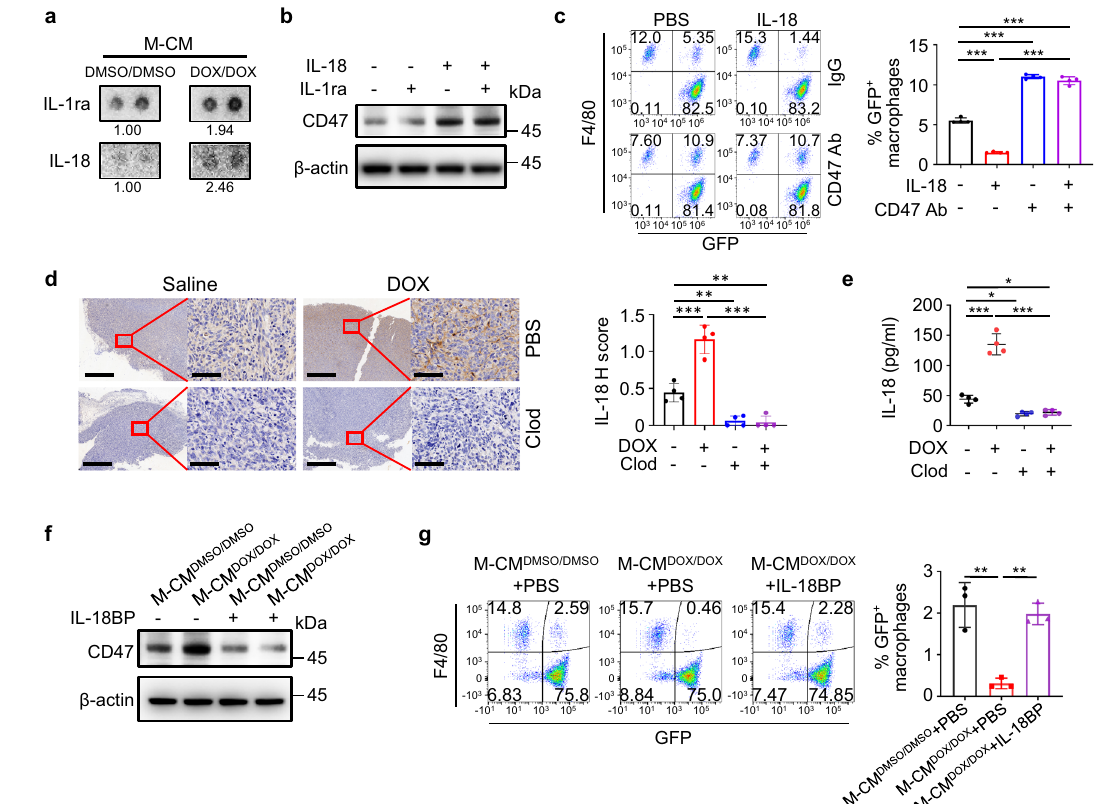
Fig. 4 | Macrophage-secreted IL-18 induces CD47 expression in osteosarcoma cells. a Analysis of cytokines in M-CM DMSO/DMSO or M-CM DOX/DOX by using a human cytokinearray. Representative images forcytokines with elevated content in TAM- CM DOX/DOX areshown.Numbersindicaterelativecytokineexpressiondeterminedby mean spot pixel density. b Western blot analysis of CD47 protein in HOS cells serum-starvedfor4hfollowedbytreatmentwiththeindicatedcytokines(40ng/ml foreachcytokine)for24h. c Flow cytometry-based invitromacrophage-mediated phagocytosisassayofHOScellsinthepresenceofIgGoranti-CD47antibody(CD47 Ab)for4h( n =4independentexperiments).HOScellswerepretreatedwithPBSor IL-18 (40ng/ml) for 24h. Macrophages were de fi ned as F4/80 + (labeled with PE) events,andtumorcellsasGFP + .F4/80 + ,GFP + eventsrepresentedmacrophagesthat hadphagocytosedtumorcells. d ImmunohistochemicalanalysisofIL-18expression in serial sections of HOS tumors treated with saline or doxorubicin (DOX), in the presenceofclodronate (Clod)liposomeorphosphatebuffersaline(PBS)liposome